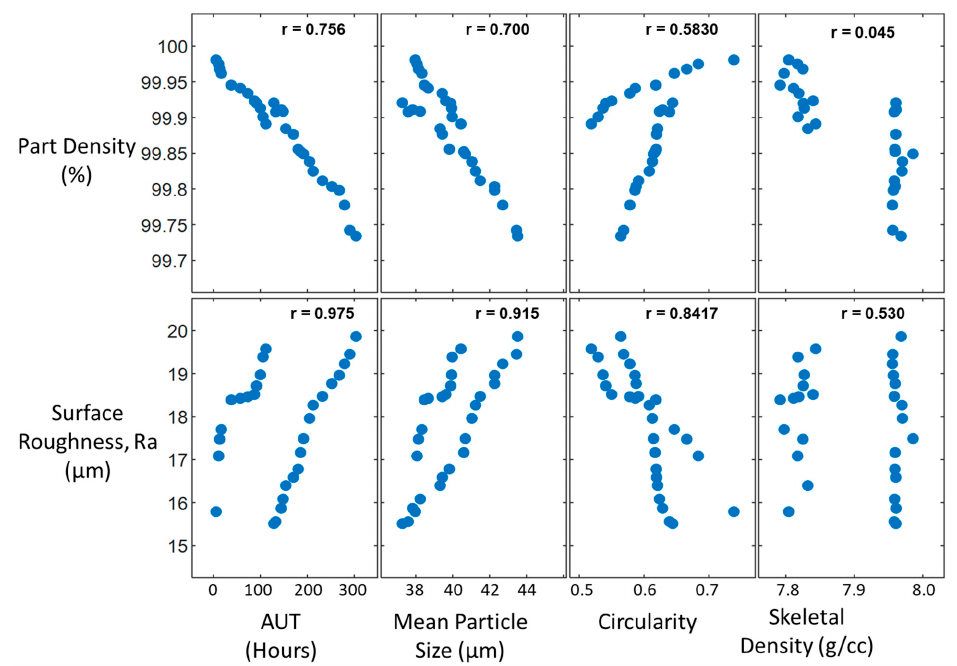
Figure 6. Scatter plots of independent variables against the dependent variables to determine those with the highest linear relationships. with the highest linear